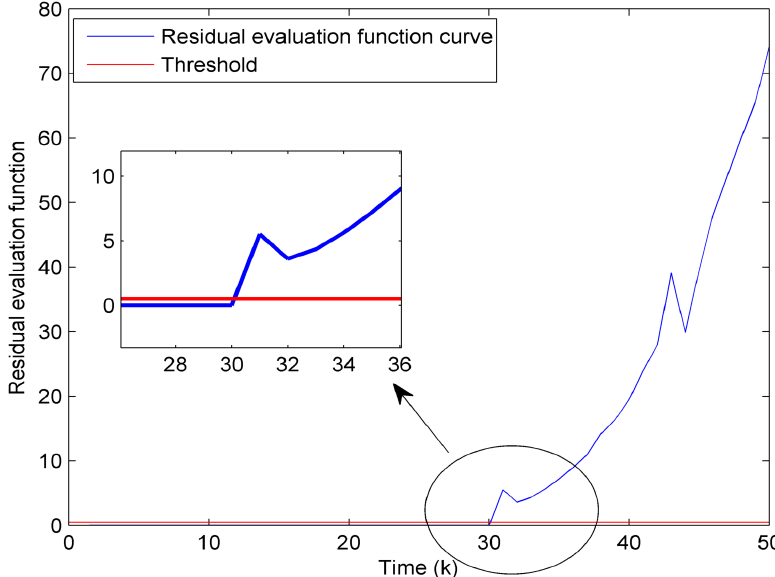
Figure 6. The residual evaluation function responses of the system with ˜ d k for a sudden-changing fault (Equation